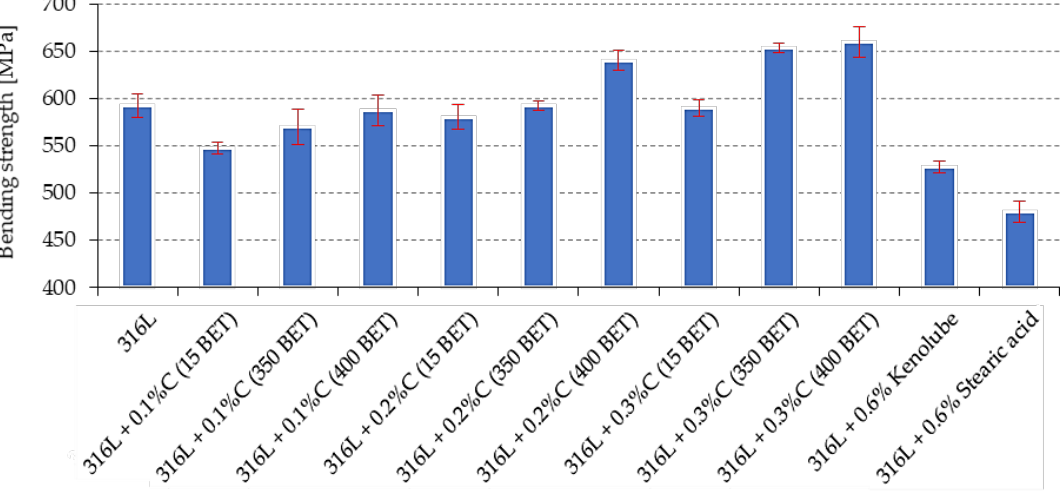
Figure 9. The bending strength of sinters depends on the percentage composition of mixtures.